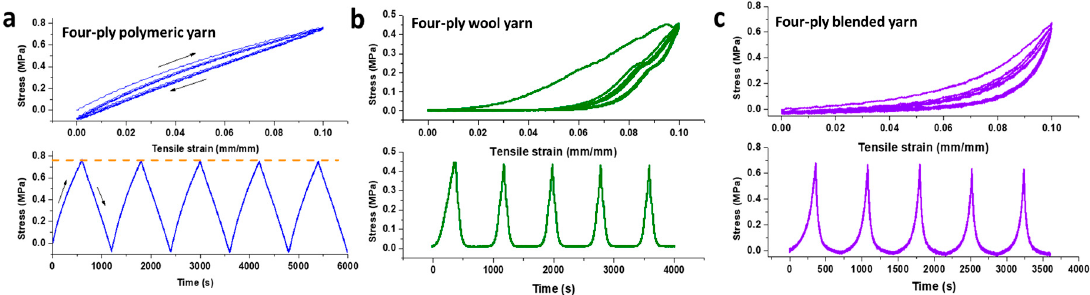
Figure 6. Isothermal tensile hysteresis cycles at T high of ( a ) stress–memory polymeric yarn, ( b ) wool yarn, and ( c ) four-ply wool yarn/polymeric yarn blends.